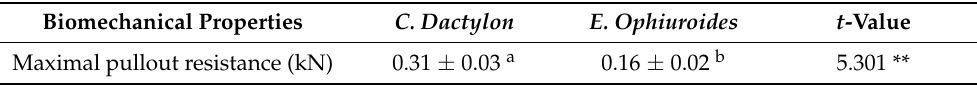
Table 3. Means ± SEs of maximal pullout resistance for the two species. Biomechanical Properties